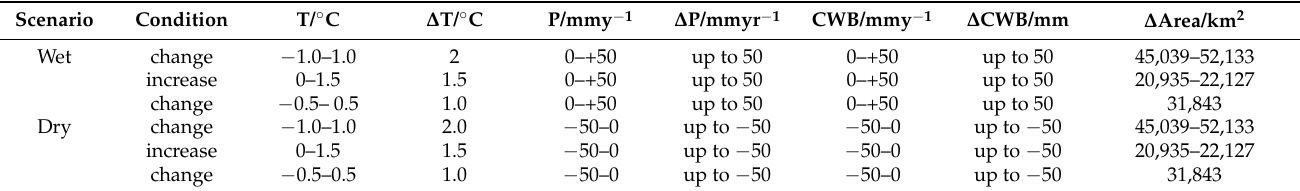
Table 4. Climatic conditions leading to abrupt land cover area changes.